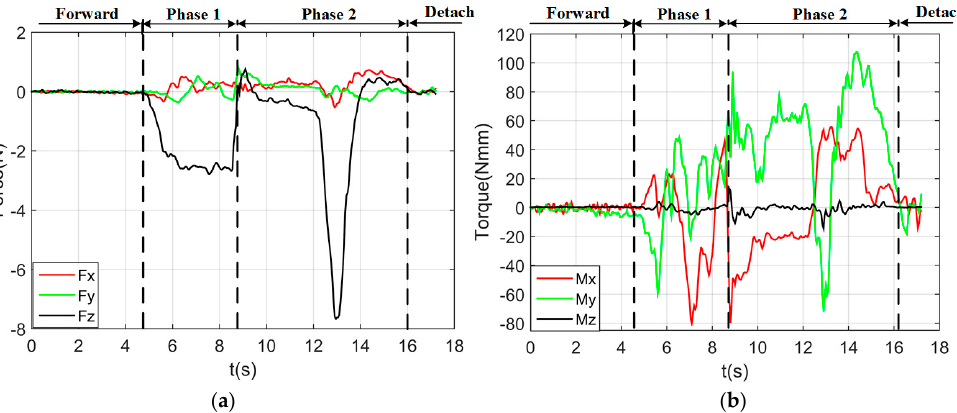
Figure 22. Round pieces: interaction forces and torques toward human beings (Phase 1: outside adjustment phase; Phase 2: inside adjustment phase). ( a ) Interaction forces; ( b ) interaction torques.